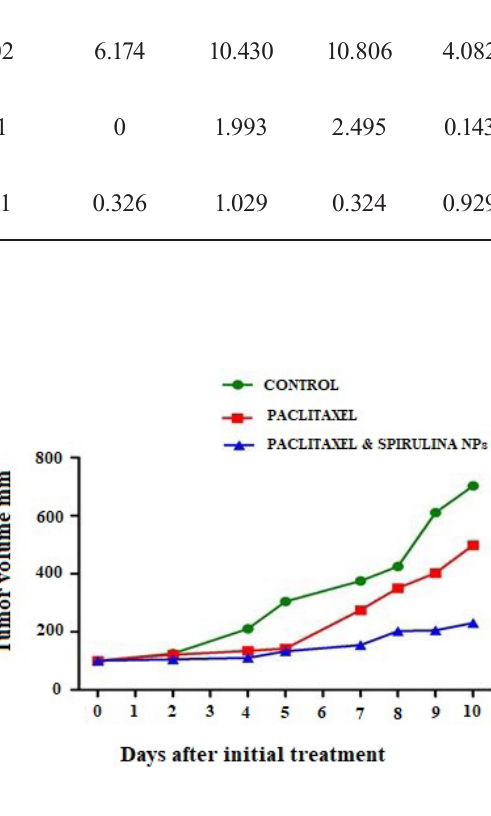
FIGURE 3 - Xenograft tumors volume change with respect to function of time. Relative tumor volume versus time is displayed.